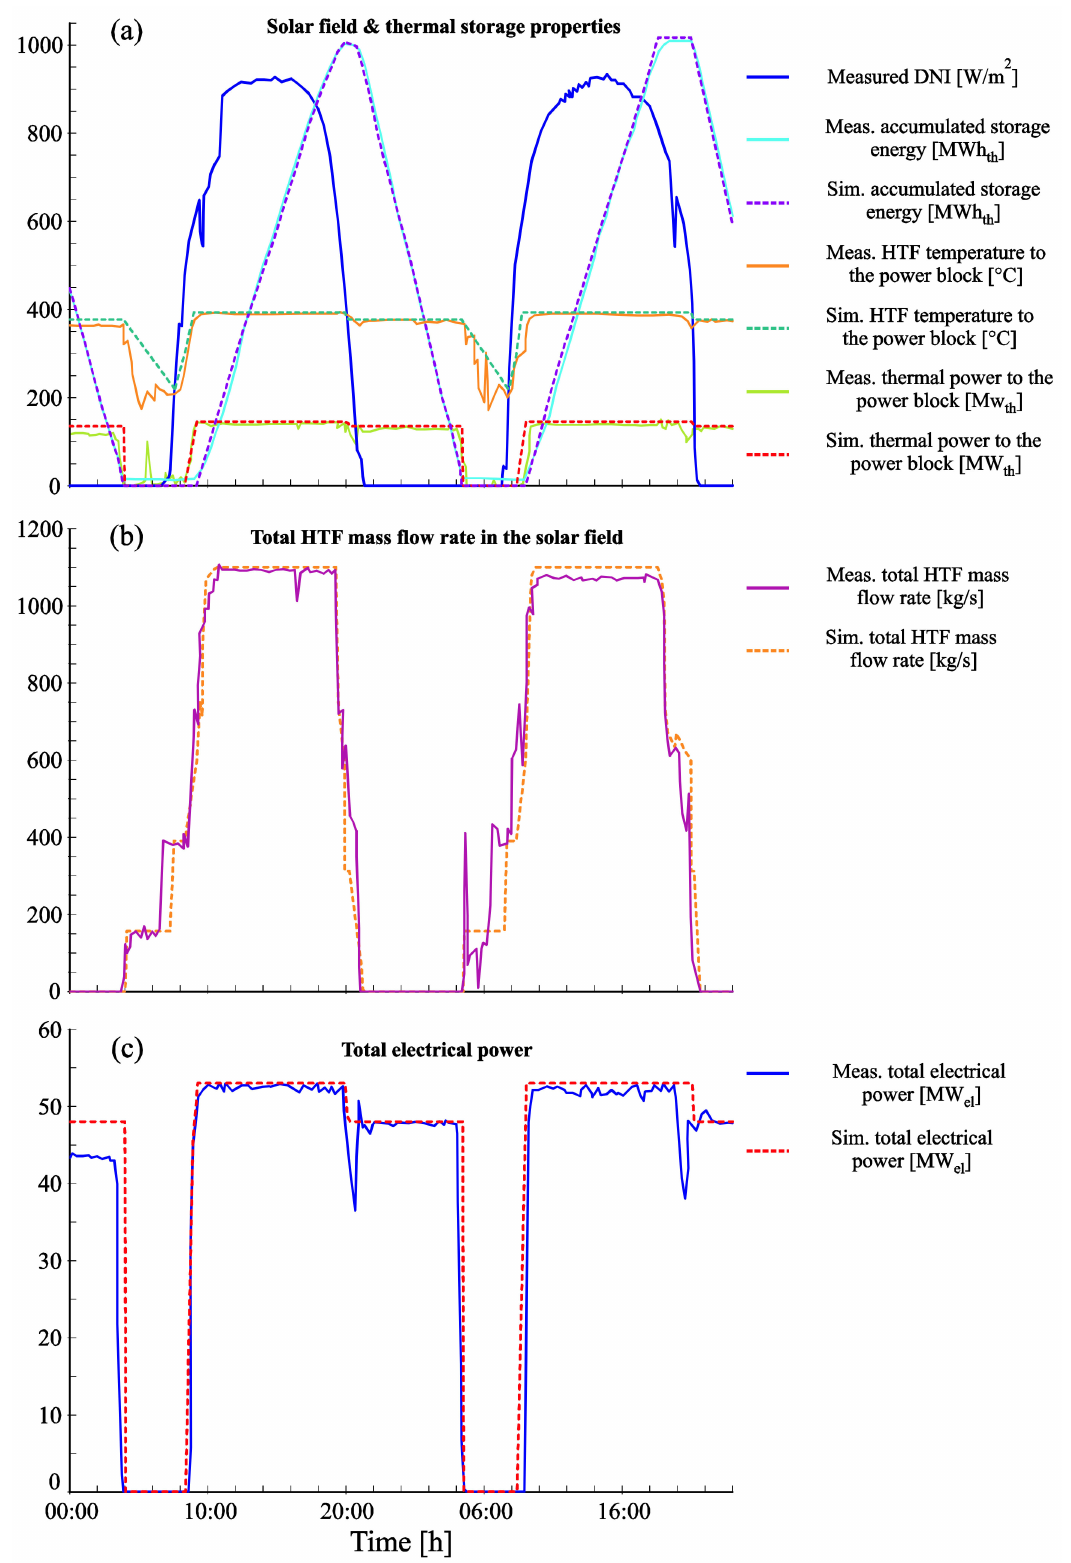
Figure 4. Comparison of measured data and simulated results for clear days